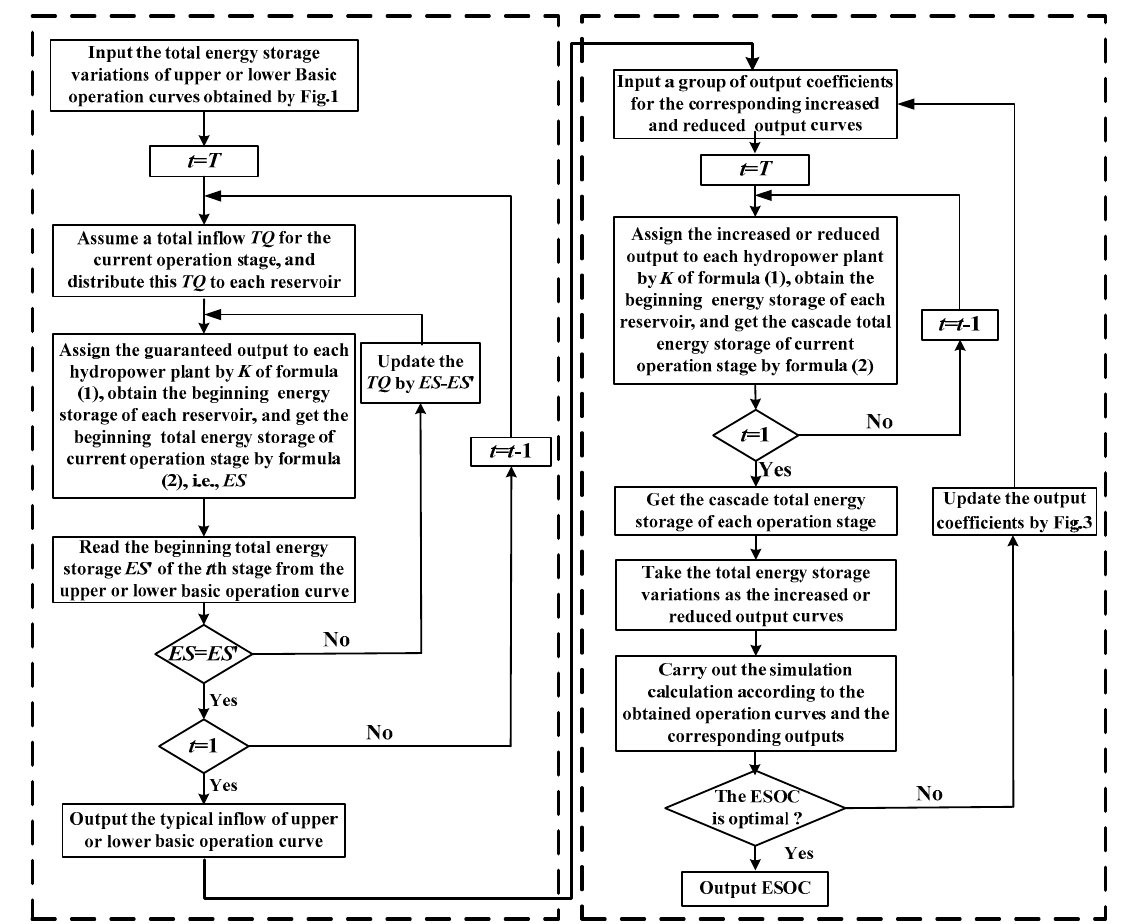
Figure 2. Inverse calculation process of drawing the increased and reduced output curves.